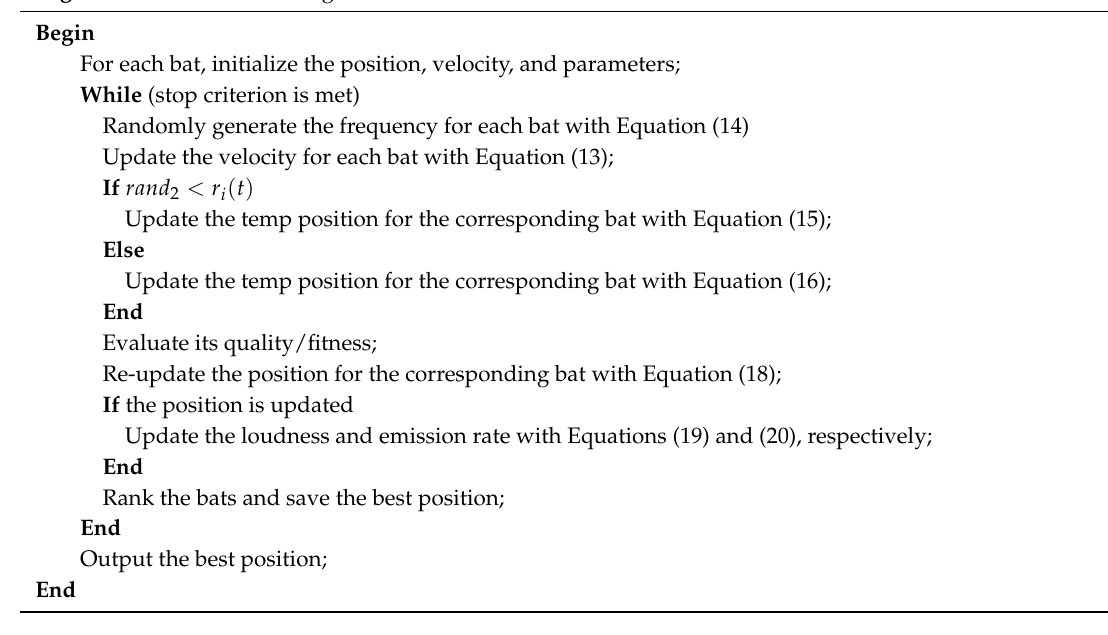
Algorithm 1. Standard bat